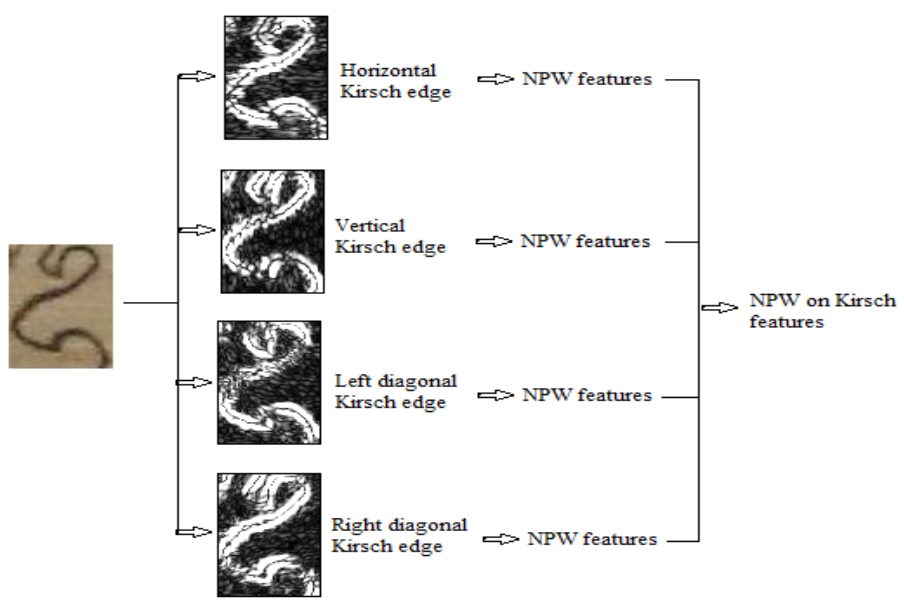
Figure 8. Scheme of NPW on Kirsch features [28].